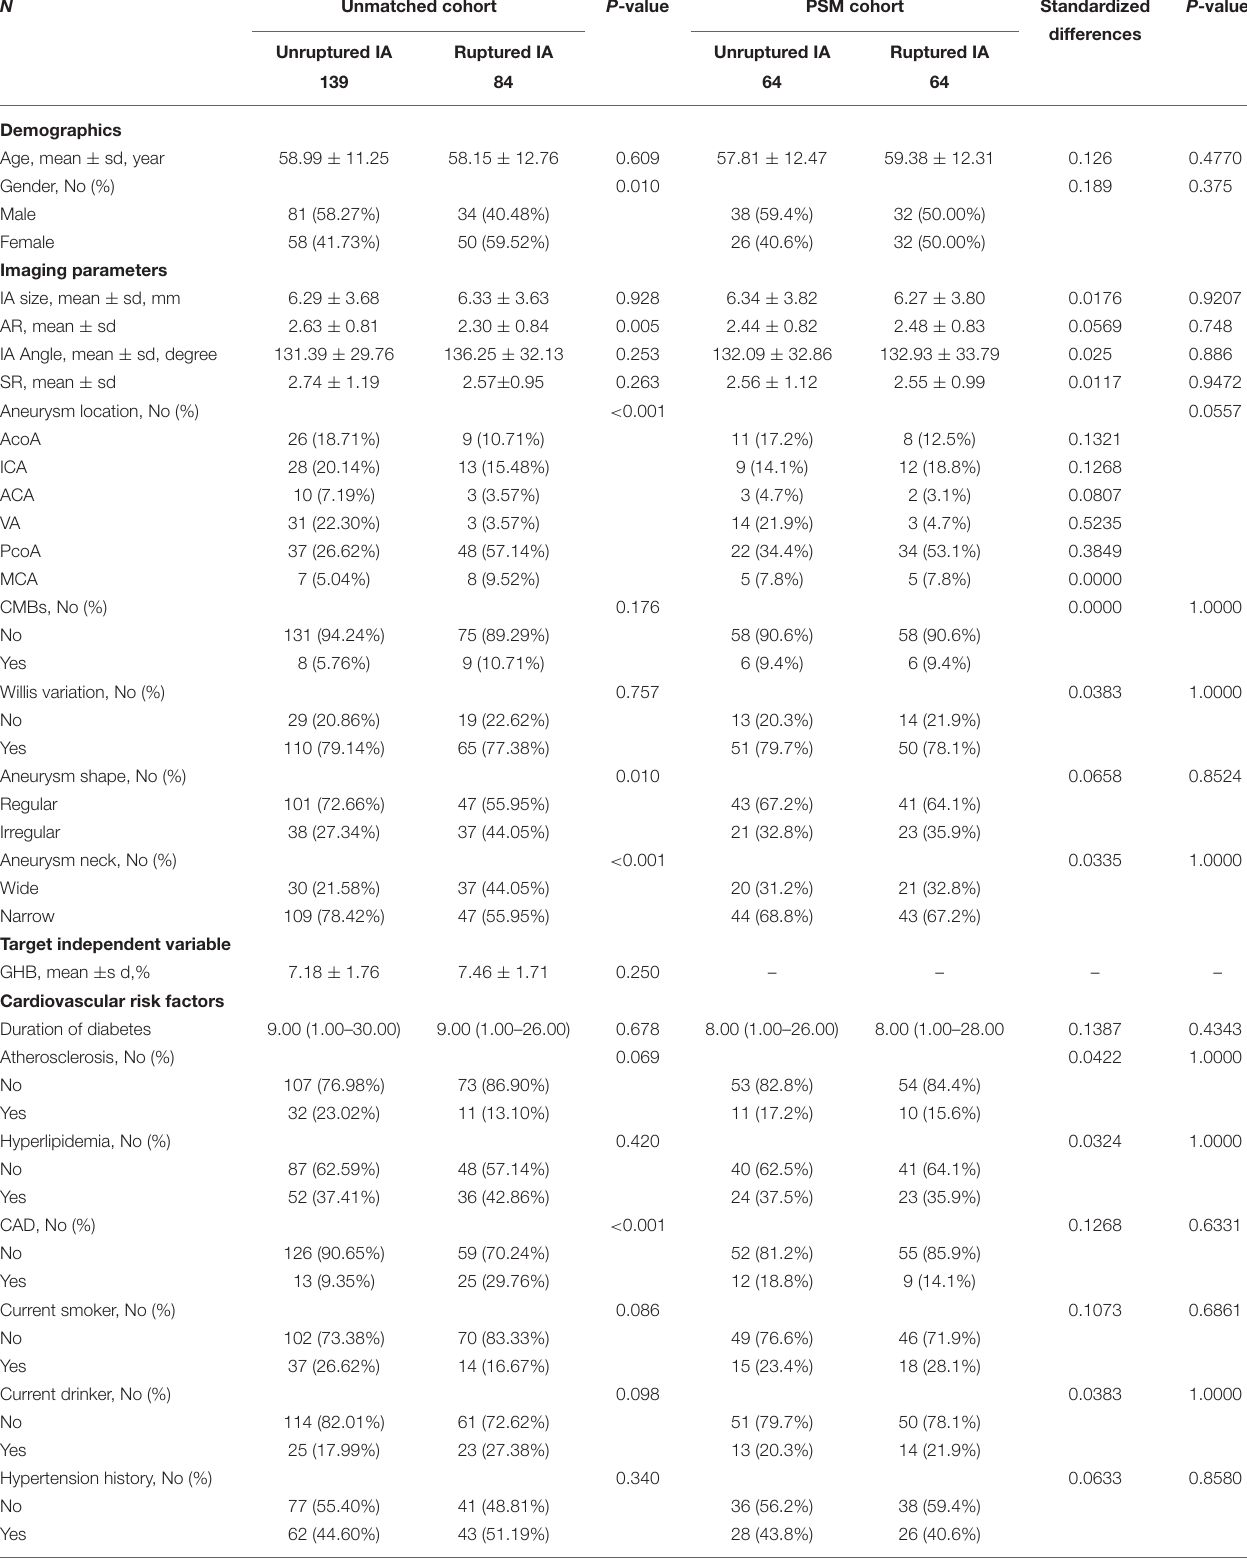
TABLE 1 | Baseline characteristics of patients with intracranial aneurysm (IA) and diabetes history. N Unmatched cohort P